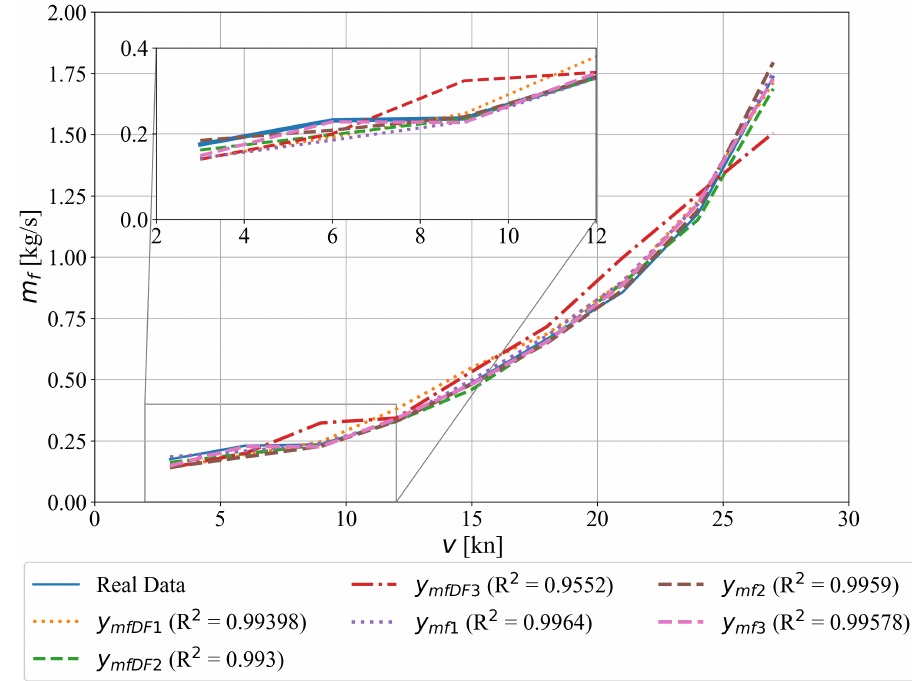
Figure 7. The comparison of estimated fuel flow with real data versus the ship